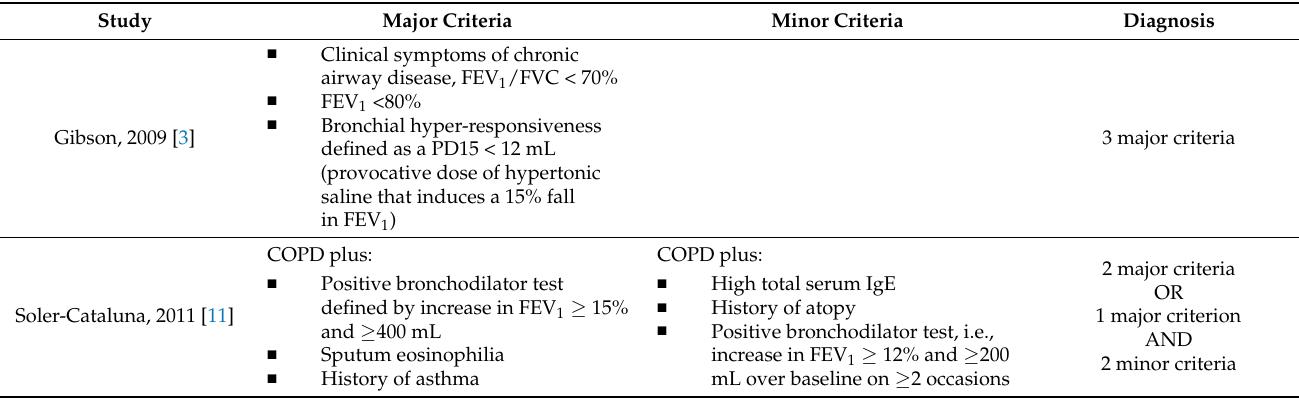
Table 1. Proposed diagnostic features of asthma and COPD overlap